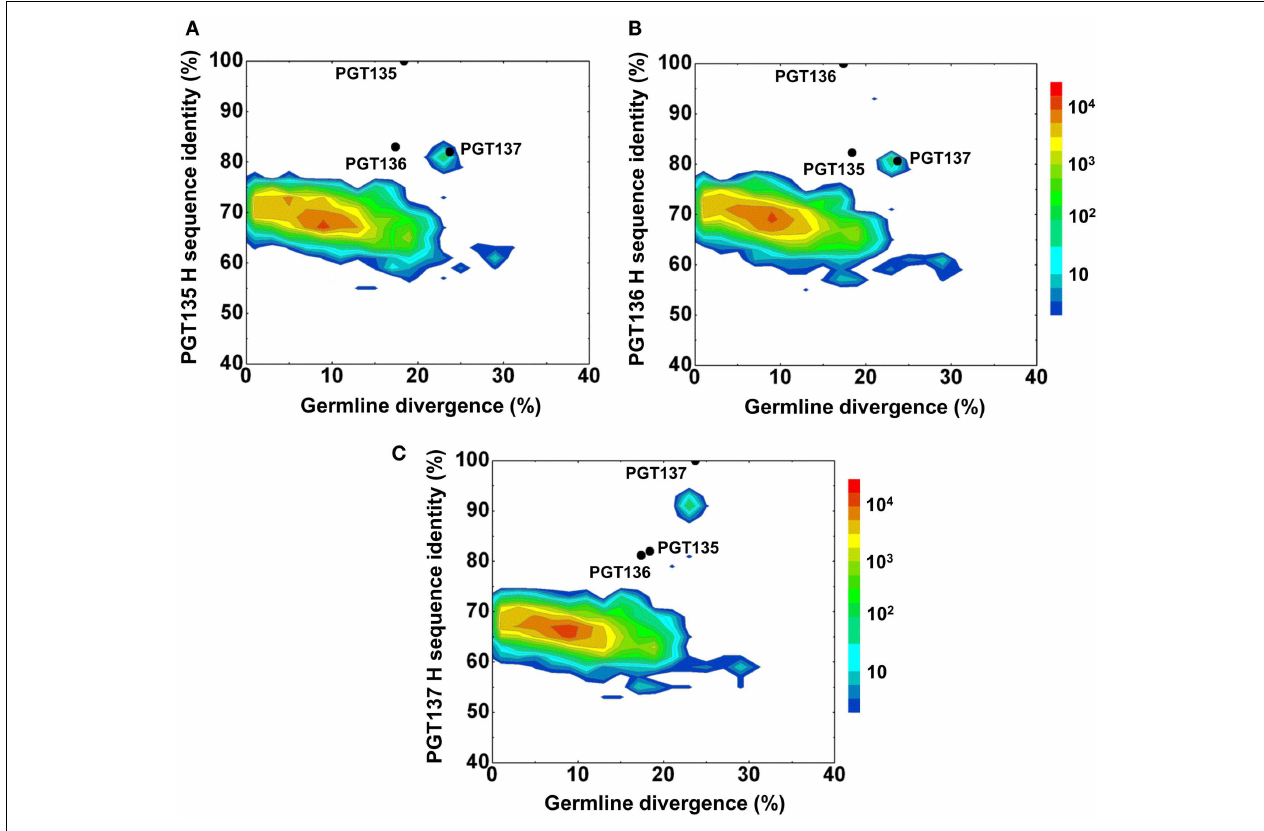
sequence identity to the heavy-chain variable domain of PGT135 (A) , PGT136 (B) , and PGT137 (C) and of sequence divergence from inferred IGHV4-39 germline allele. Color coding indicates the number of sequences.The 10%-identity gap indicates that the sequences within the upper island in 2C are somatic variants of PGT137 and not caused by sequencing